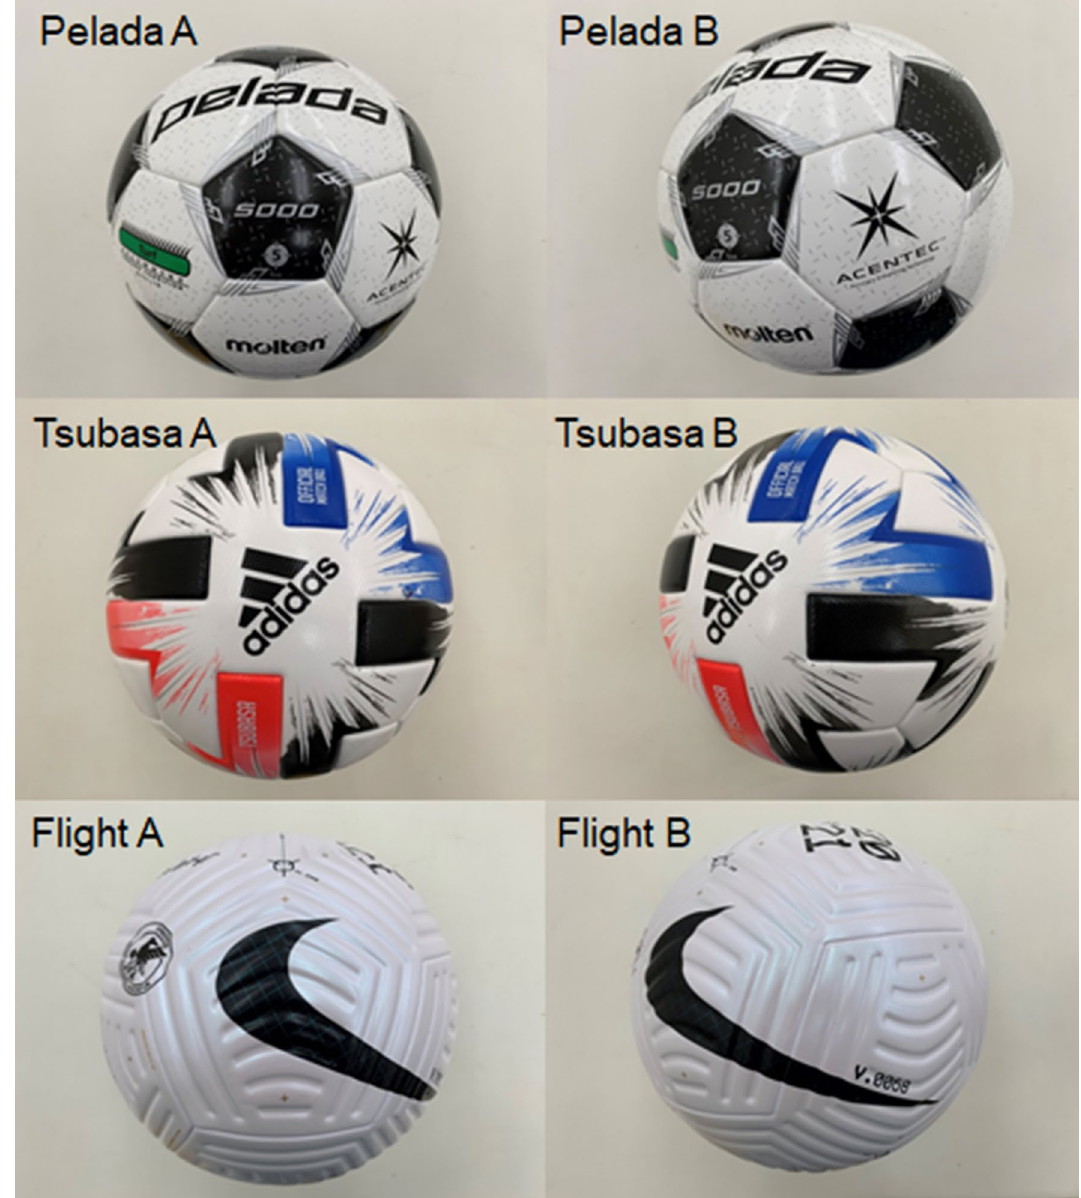
Figure 2. Footballs used for the test and their panel orientations: Pelada A and Pelada B (32 panels, Molten), Tsubasa A and Tsubasa B (6 panels, Adidas), and Flight A and Flight B (4 panels, Nike). A indicates a symmetric orientation while B indicates an asymmetric